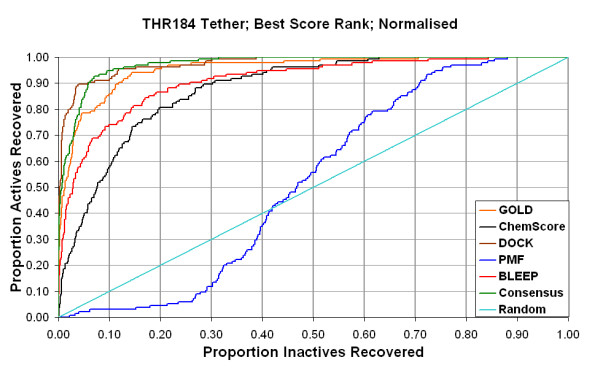
Receiver Operating Characteristic (ROC) curves for the combination of the Thrl84 tether, the BestScorerank protocol, and normalisation by dividing the raw score by the number of heavy atoms to the power of 1/3.